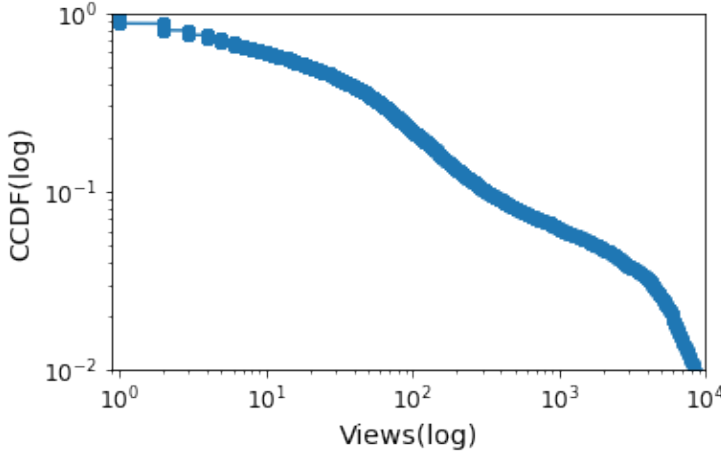
Figure 3. Complementary cumulative distribution function of number of views in log